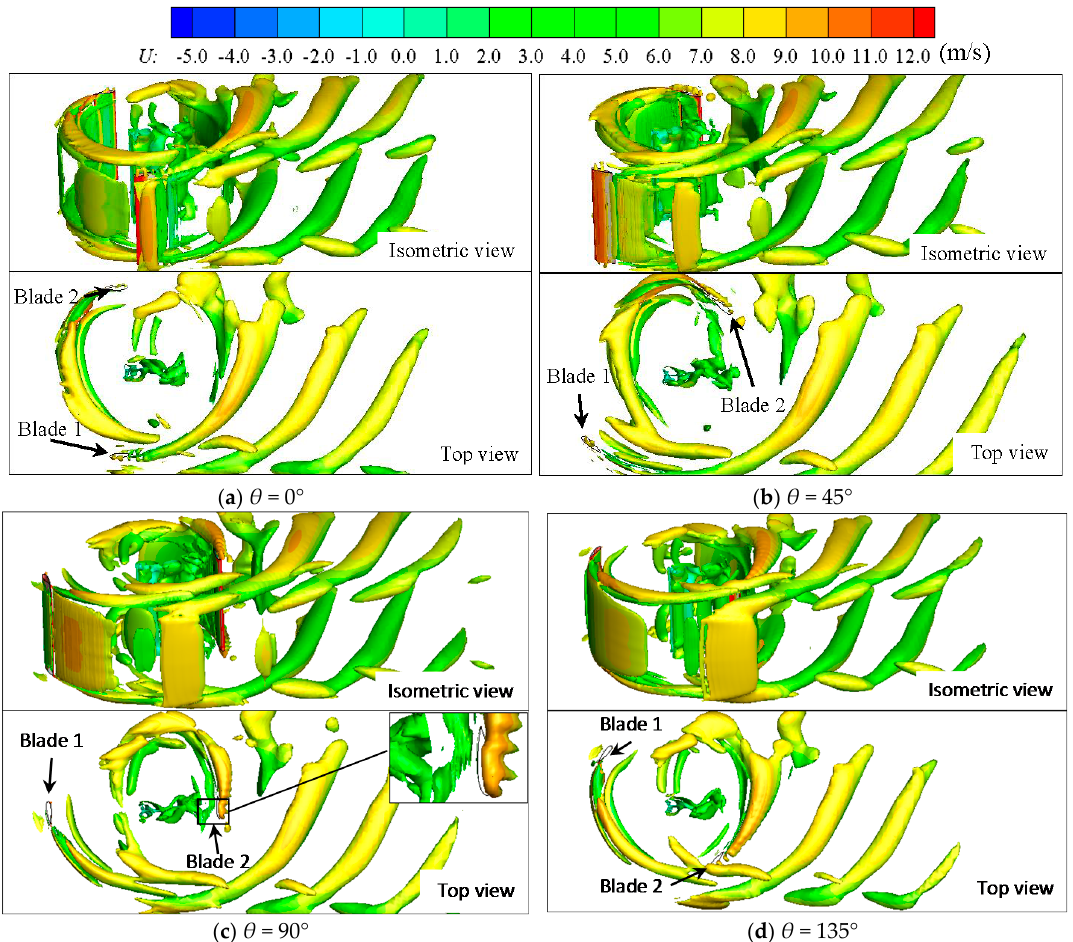
Figure 8. Q -criterion iso-surface of vortex structure for rotor with the azimuth angle of ( a ) θ = 0°, ( b ) θ = 45°, ( c ) θ = 90° and ( d ) θ = 135° at TSR = 2.58. Contour of Q -criterion iso-surface depicts the wind velocity of U .